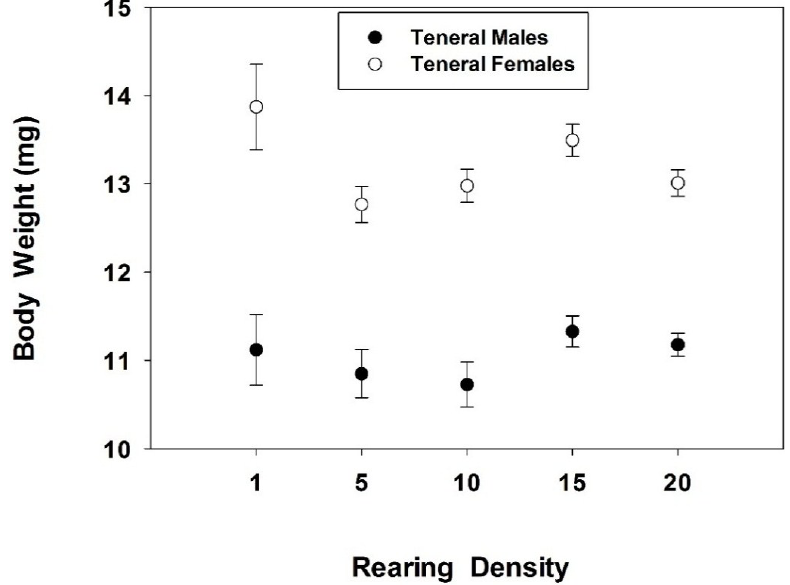
Figure 2. Mean ± SE body weight of teneral adults in relation to rearing density. A total of 208 males and 221 females were in the